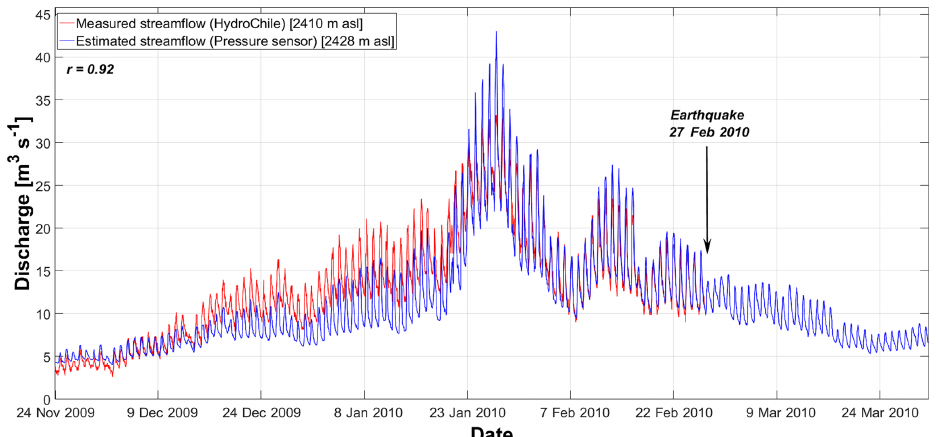
Figure 10. Time series of hourly discharge in the proglacial stream from the water level pressure sensor and the HydroChile gauging station.